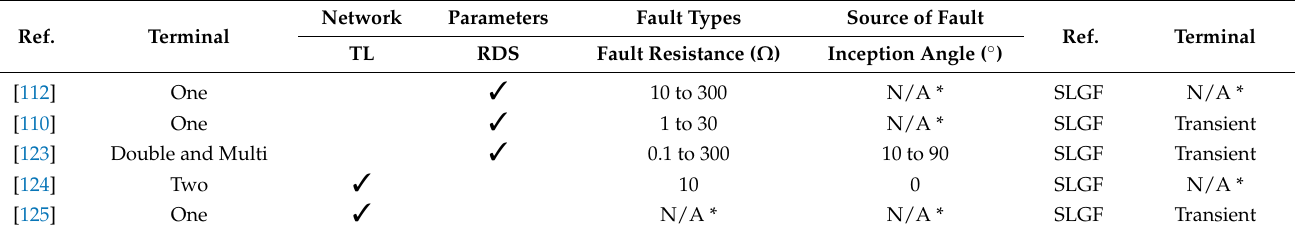
Table 5. Fault location using the travelling wave